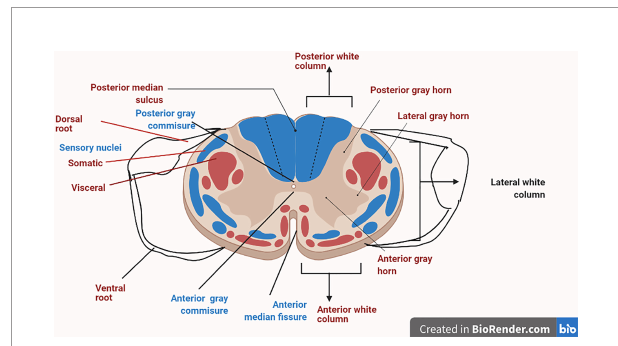
FIGURE 1 | Sectional organization of the spinal cord showing the dorsal root